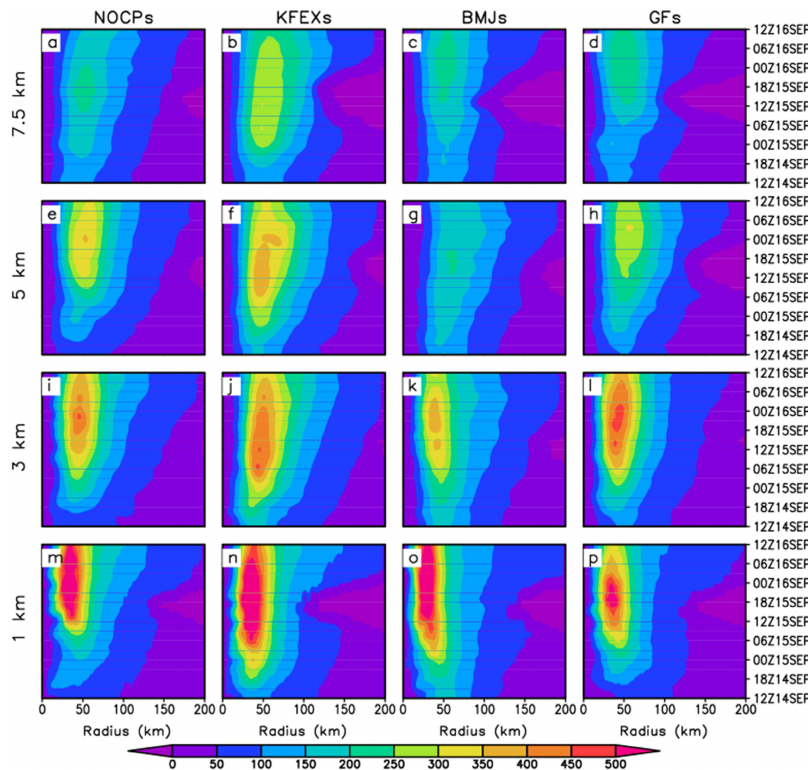
Figure 6. Hovmöller diagrams of the azimuthal-averaged radial pressure gradient (kg m − 2 s − 1 h − 1 ) at 100 m height. The model resolution is 7.5 km ( a – d ), 5 km ( e – h ), 3 km ( i – l ) and 1 km ( m – p )